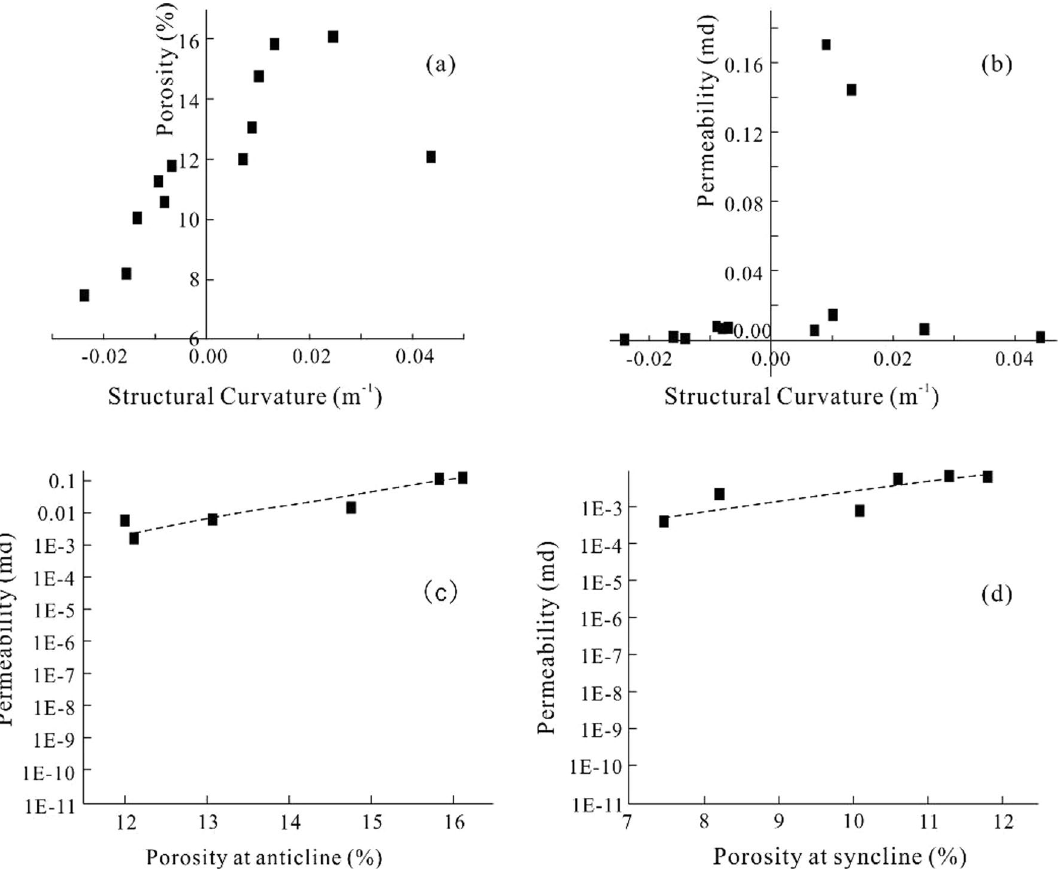
Fig. 5 Interaction of permeability with structural curvature and porosity. a the relationship between structural curvature and poros- ity, b the relationship between structural curvature and permeability,